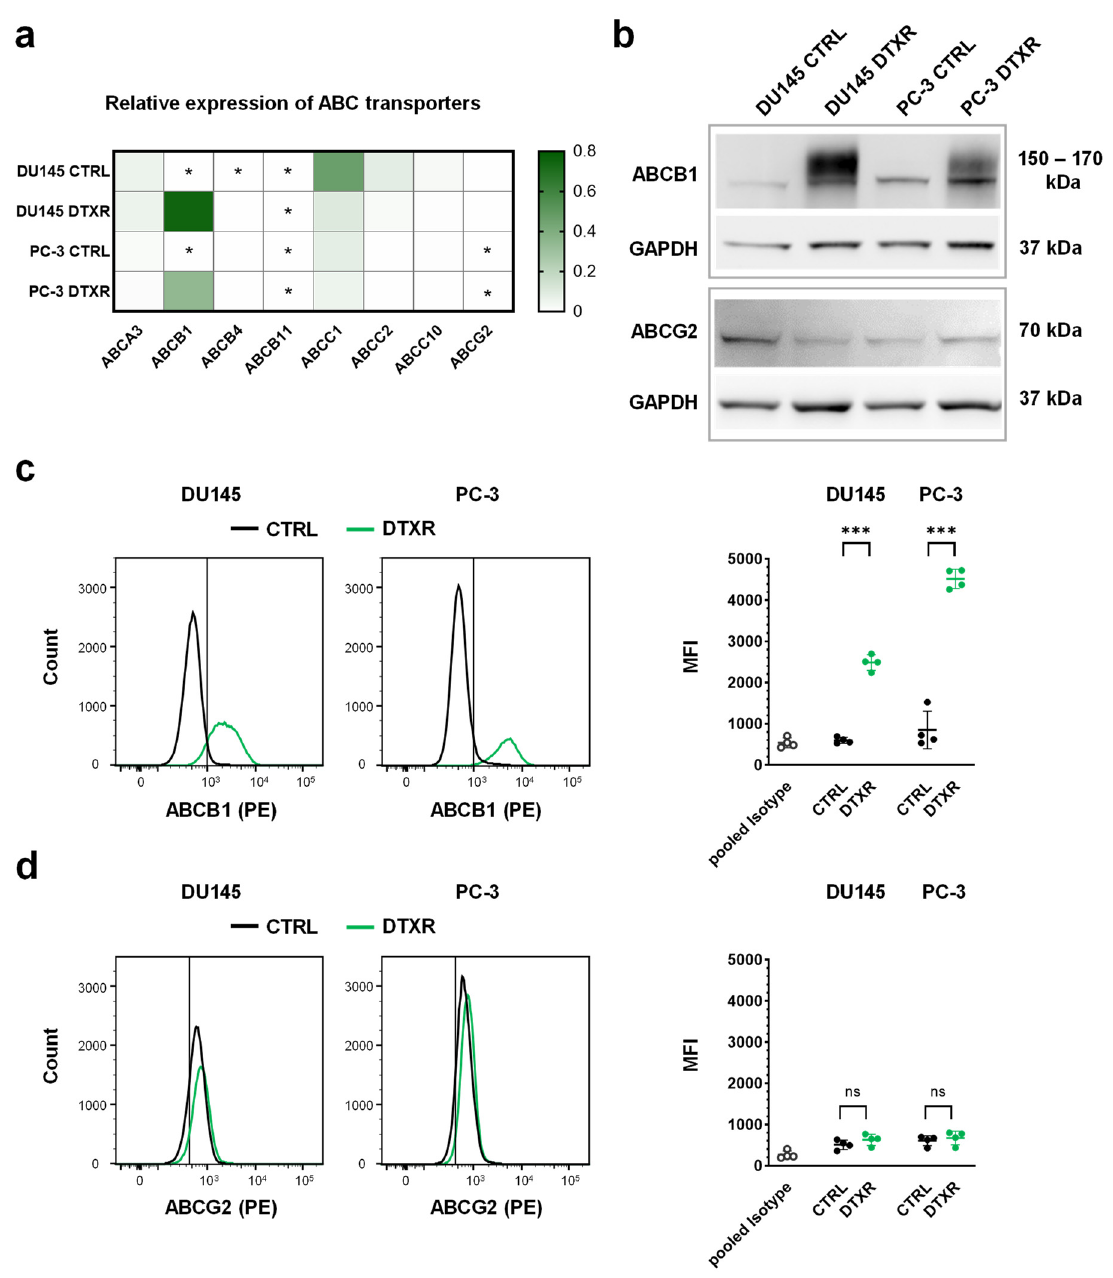
Figure 1. RNA and protein expression of selected ABC transporters, which are known to be involved in taxane resistance and/or MDR, in DU145 and PC-3 DTXR cells compared to CTRL cells. ( a ) The relative transcript levels of eight selected ABC transporters were plotted on a heat map. Cells with an expression of the respective ABC transporter beyond the detection threshold (CP ≥ 35) are marked with an asterisk (*). ( b ) Exemplary Western blots for detecting ABCB1 and ABCG2 proteins in CTRL and DTXR cells. GAPDH served as a reference protein. ( c , d ) Exemplary flow cytometry analysis for ( c ) ABCB1 and ( d ) ABCG2 proteins via specific antibodies conjugated with the fluorescent phycoerythrin (PE) in CTRL and DTXR cells. The vertical black lines indicate the threshold of unspecificity according to the pooled isotype controls. The adjacent graphs to the right depict the median fluorescence intensities (MFI) for ABCB1 and ABCG2 protein, respectively. Data are depicted as mean ± standard deviation (SD) of three to four independent biological replicates. Non-paired t-test with Welch’s correction was performed for comparison of CTRL vs. DTXR cells: *** p < 0.001, ns: not significant.